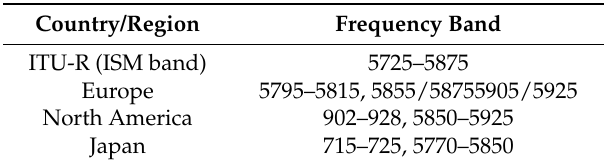
Table 1. Spectrum allocation for wireless access in vehicular environments (WAVE)/dedicated short-range communication (DSRC)